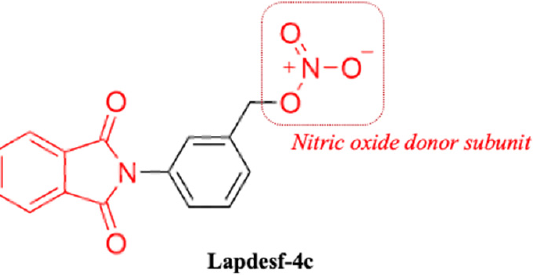
Figure 1. Chemical structure of 3-(1,3-dioxoisoindolin-2-yl) benzyl nitrate ( Lapdesf-4c ).